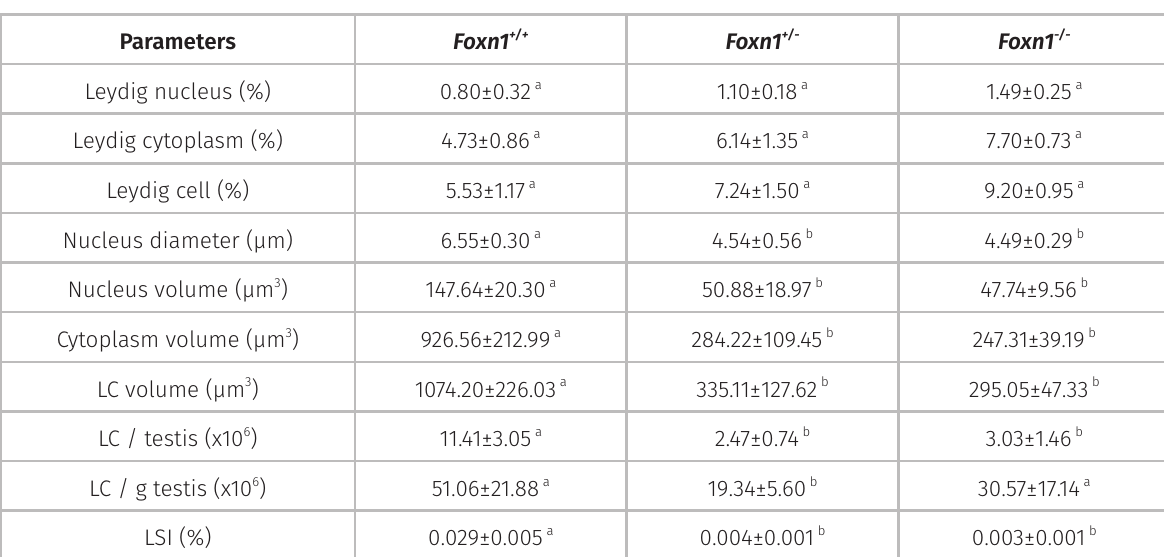
Table V. Leydig cell morphometry and